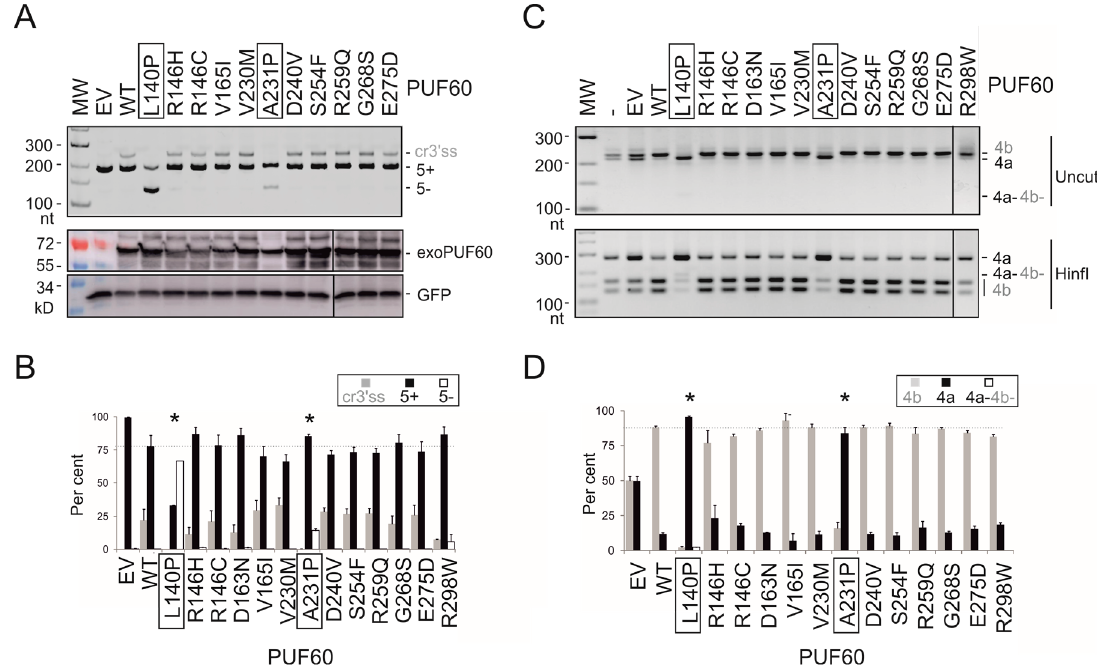
Figure 4. Splicing activities of cancer-associated PUF60 RRM substitutions. ( A ) UBE2F splicing pattern induced by PUF60 expression constructs with the indicated RRM substitutions (upper panel). A corresponding immunoblot is in the lower panel. ( B ) Relative usage of RNA products shown in panel A. Bar charts represent the means of duplicate transfections ± SEM. Dotted line indicates canonical transcripts induced by the WT protein. Amino acid substitutions with significant deviations from the WT ( p < 0.05) are denoted by asterisks at the top and are boxed at the bottom. One-way analysis of variance was performed with Dunnett’s multiple comparison post-hoc t-tests. ( C ) Mutually exclusive usage of OGDH exons in HEK293 cells expressing the indicated constructs. For better resolution, undigested products (upper panel) were also digested with HinfI, which only cleaves exon 4b (lower panel). ( D ) Measurements of mRNA isoforms shown in panel C. Bar charts represent the means of duplicate transfections ± SEM. Dotted line indicates 4b transcripts induced by the WT protein. Amino acid substitutions with significant deviations from the WT ( p < 0.05) are denoted by asterisks at the top and are boxed at the bottom. Analysis of variance was followed by Dunnett’s post-hoc t-tests.